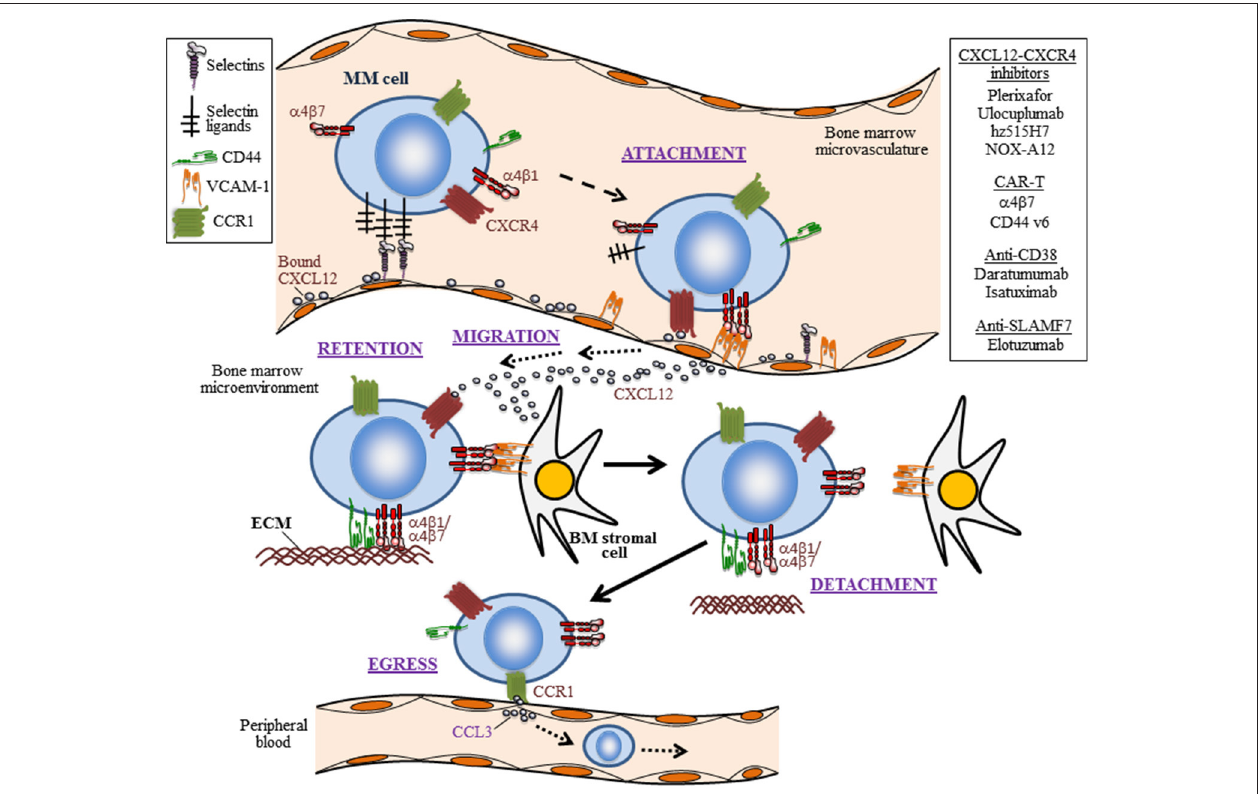
FIGURE 1 | The trafficking life of MM cells. Depicted are five steps (attachment, migration, retention, detachment, and egress) in the trafficking of myeloma cells into the BM and their escape to the periphery, as well as some of the involved trafficking receptors and their ligands. The initial attachment of MM cells to the BM microvasculature is controlled by selectins, the CXCL12-CXCR4 axis, and the α 4 β 1 integrin interaction with VCAM-1. Importantly, CXCL12-CXCR4 leads to upregulation of α 4 β 1-dependent MM cell adhesion. The migration and retention of MM cells in the BM is contributed by the CXCL12-CXCR4 chemoattraction module, by adhesion mediated by the integrins α 4 β 1 and α 4 β 7, as well as by CD44. Ligands for these adhesion receptors are components of the extracellular matrix (ECM), such as fibronectin and hialuronic acid. Weakening or disrupting these adhesive interactions causes MM cell detachment from the BM microenvironment and egress to peripheral blood. The homing of MM cells to the BM can be inhibited by the CXCL12 inhibitor NOX-A12, and neutralizing CXCL12 binding to CXCR4 with the plerixafor blocks MM cell interaction with the BM microenvironment. A putative active cell egress mechanism is proposed as depicted by the CCL3-CCR1 interaction. Not shown is the trafficking of circulating MM cells to extramedullary colonization sites. In addition to therapies targeting the CXCL12-CXCR4 axis, the use of CAR T cells addressing α 4 β 7 and CD44, and humanized monoclonal antibodies against CD38 and SLAMF7, which are currently being tested in MM, are